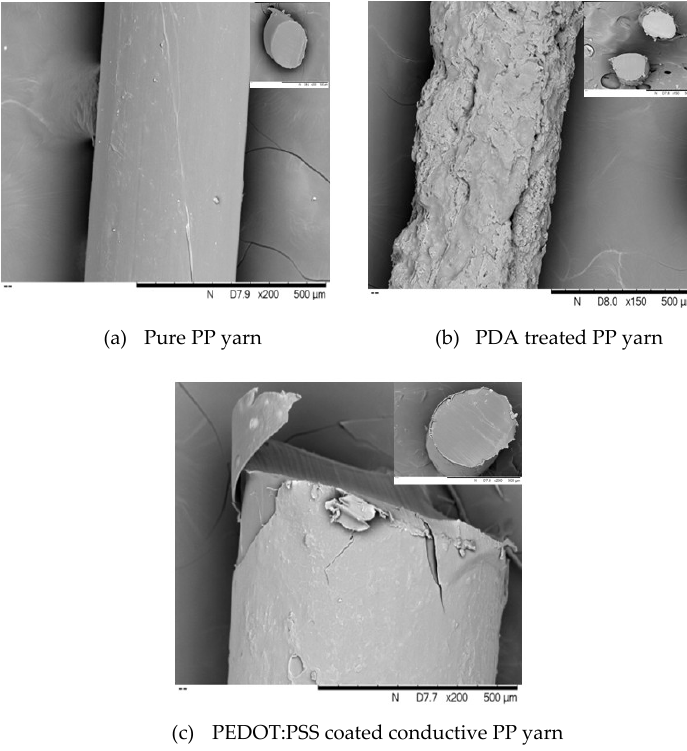
Figure 9. SEM images (surface and cross-section) of PP yarn at various stages.